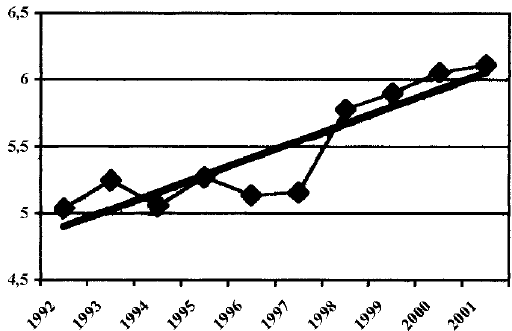
FIG. 2. Mean paper size per publication